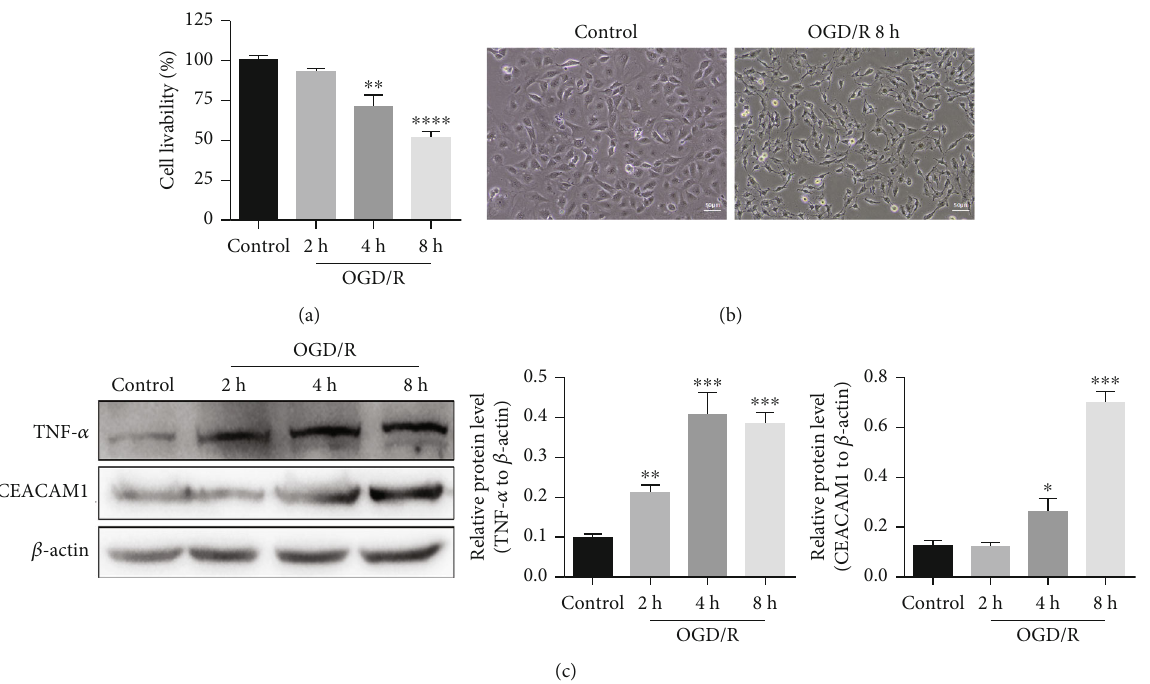
Figure 1: Culture of HPMVECs under OGD/R results in loss of cell viability and increased expression of CEACAM1 and TNFa. (a) Increased time under hypoxic conditions resulted in decreased cell viability in wild type HPMVECs. Assays were performed as biological replicates of three. The 8 h OGD-treated group exhibited signi fi cantly lower viability than 4h OGD-treated group ( p < 0 : 05 ). (b) Extended hypoxia yields smaller and more spherical cells and lower cell numbers compared to controls. (c) Increased time under hypoxic conditions leads to increased expression CEACAM1 and TNF- α